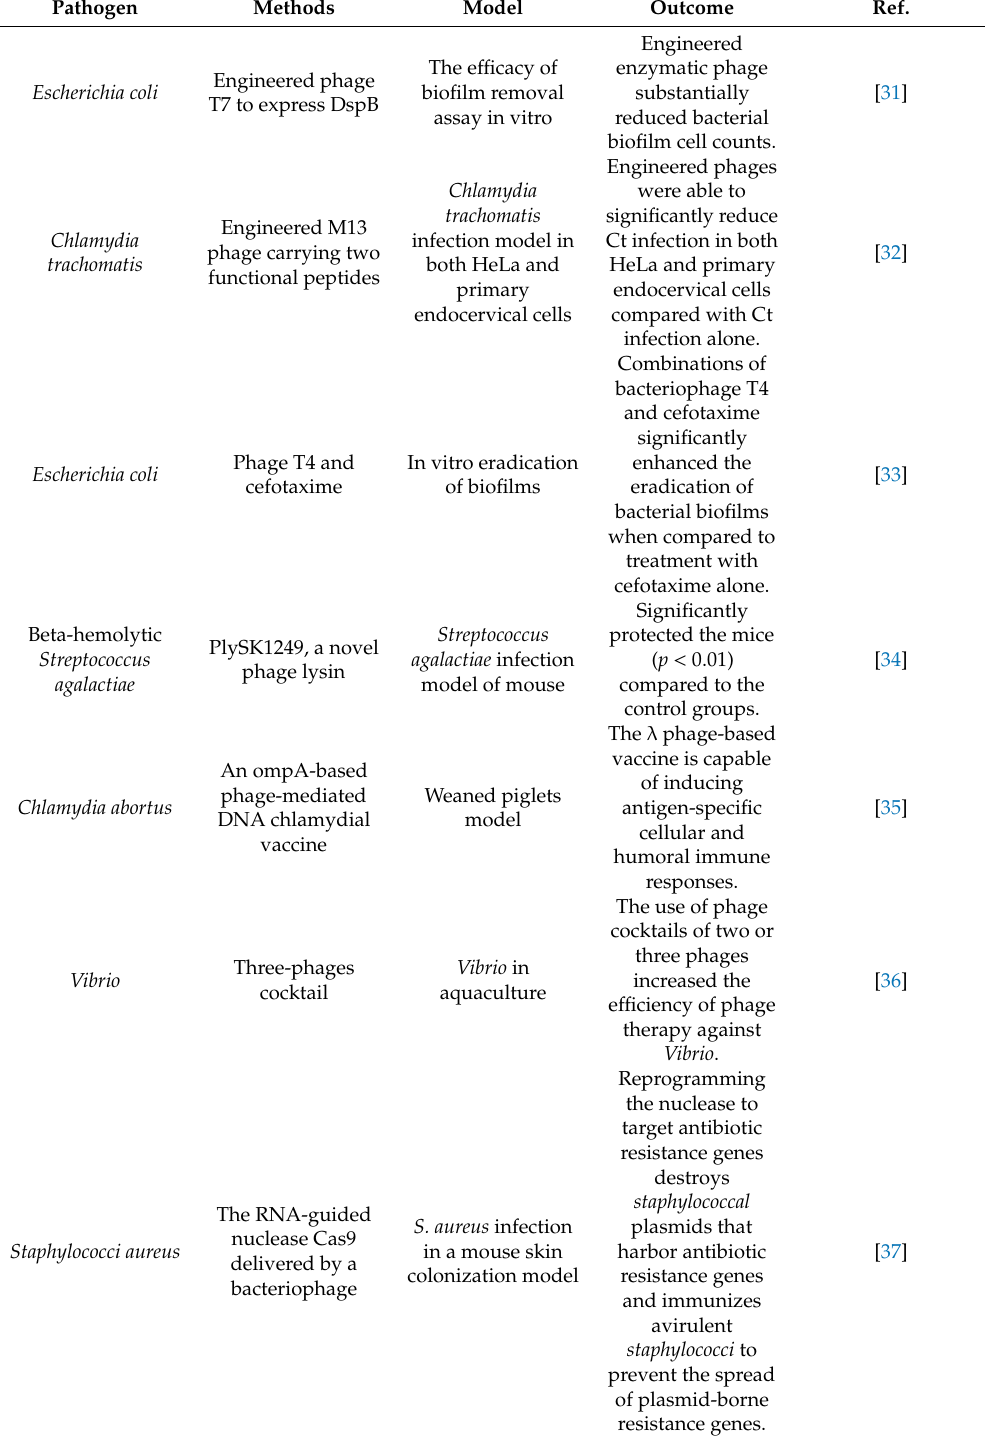
Table 1. Representative studies and reports on phage therapy in recent